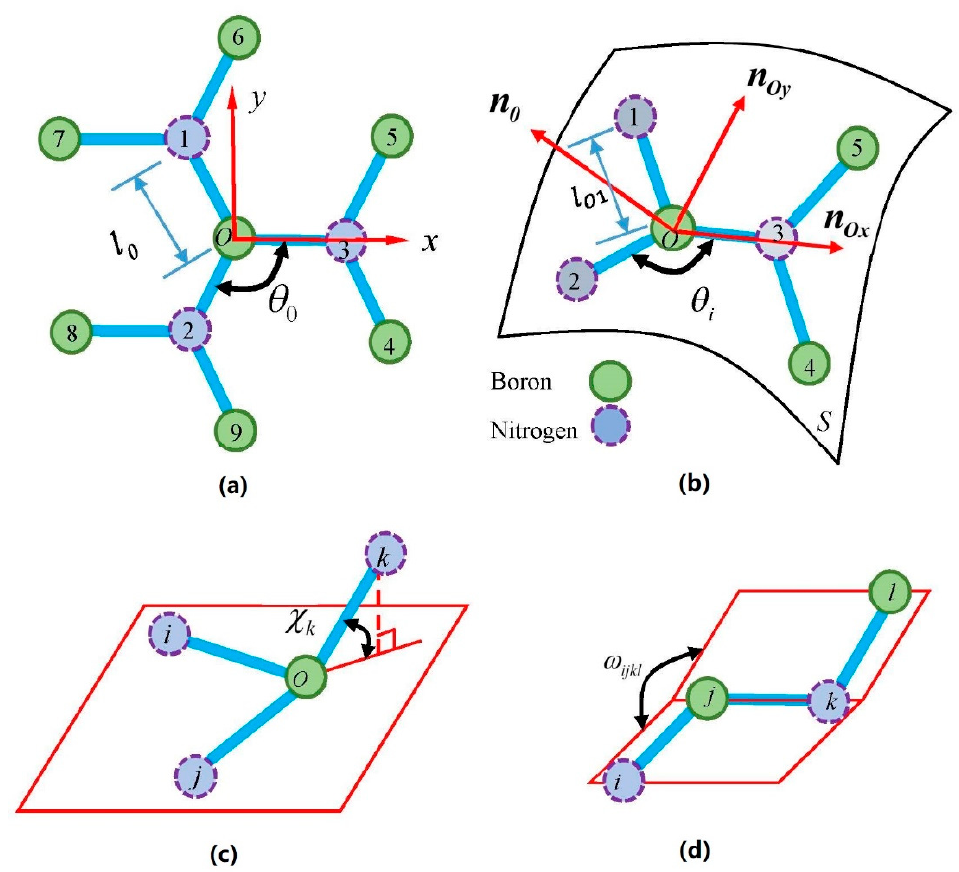
Figure 1. Fragment of single-layer h-BN: ( a ) undeformed structure; ( b ) atoms in the deformed surface; ( c ) four-body inversion angle; ( d ) four-body dihedral